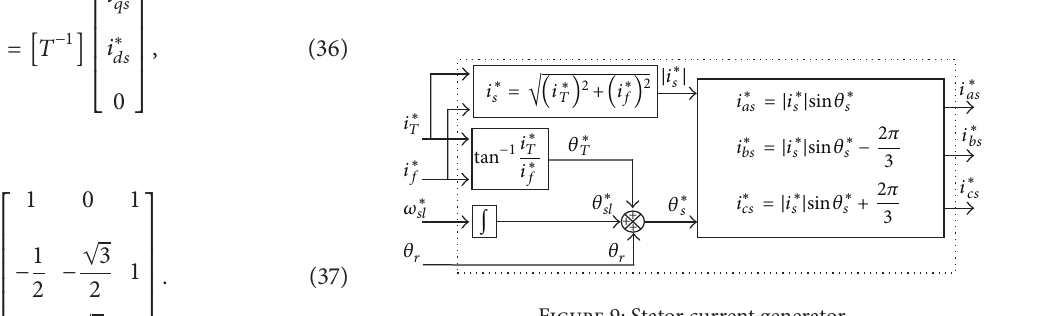
Figure 8: Simplified diagram for IFOC method.